Question: Which visualization type does this figure use?
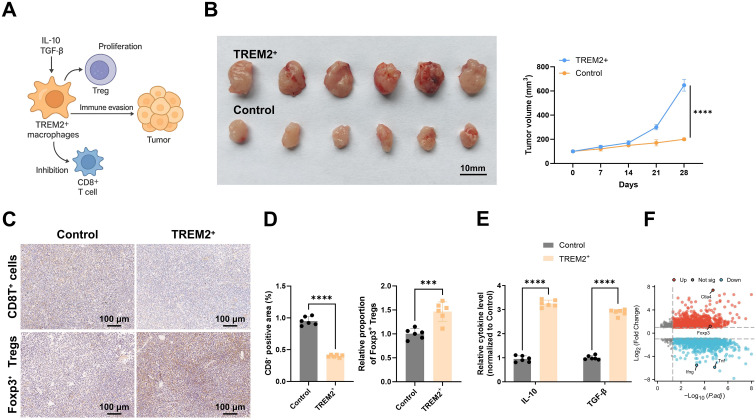
Answer: line